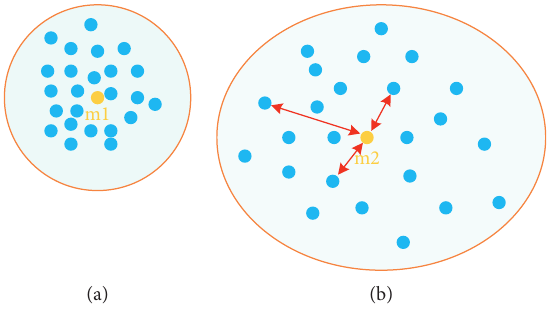
Figure 1: Biclustering algorithm. (a) C1. (b)